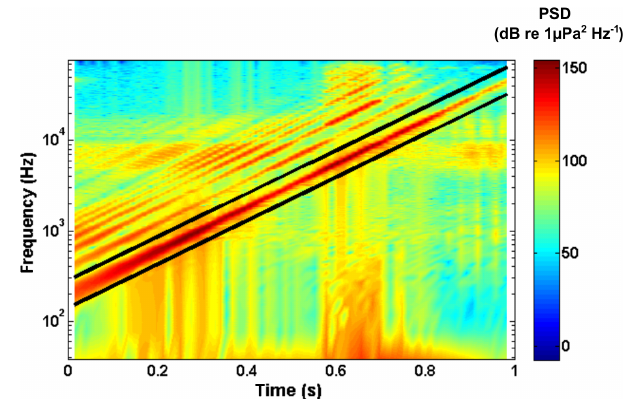
Figure 4. Short-term spectrogram of a chirp monitored by a hy- drophone in the Leysse River. The black lines indicate the octave band centered around the instantaneous frequency of the theoretical logarithmic